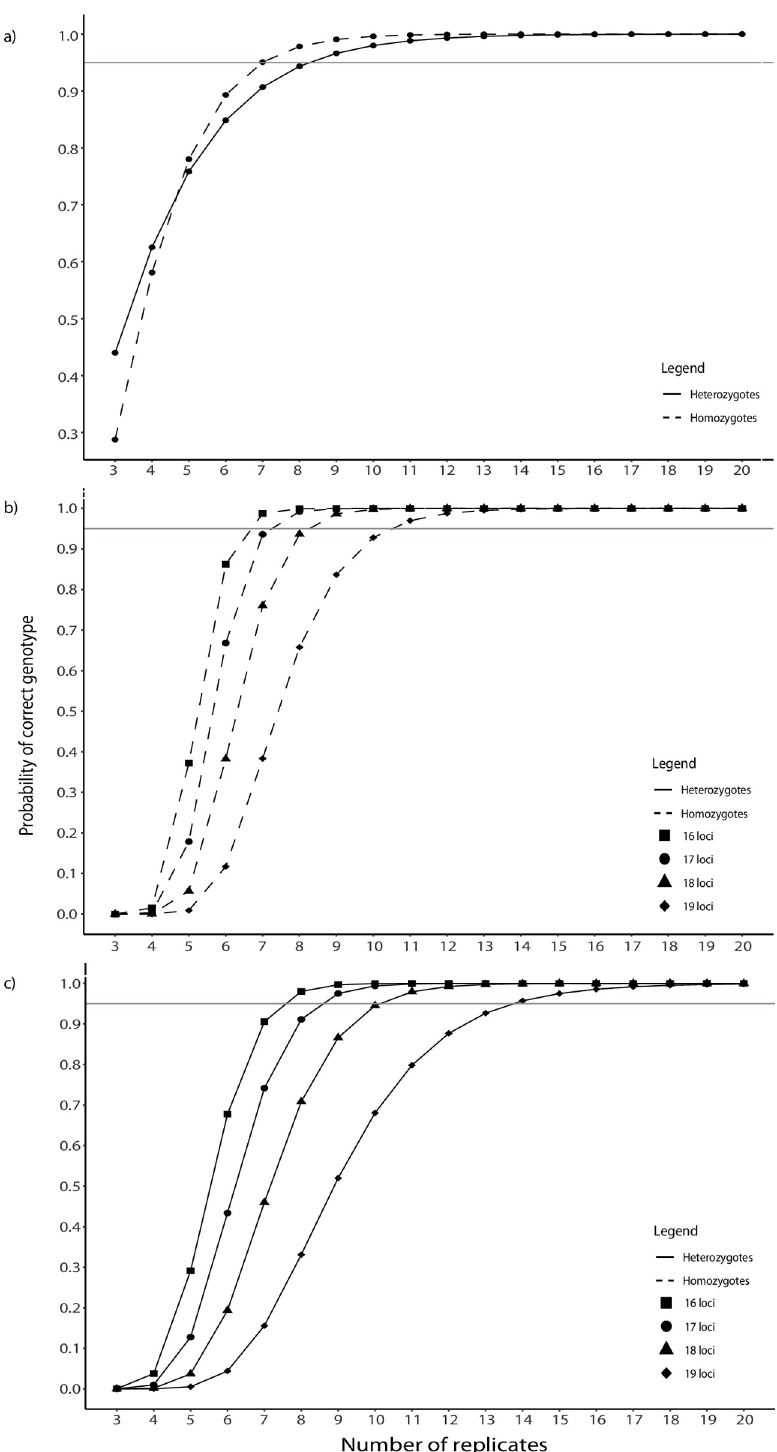
Fig 3. Relation between genotyping success and number of replicates using Megasat. Single locus (a): although the probability of genotyping success is higher for homozygotes (0.66; dashed line) than for heterozygotes (0.46; solid line), seven independent replicates are required to determine a homozygous genotype in a noninvasive sample, while eight were for a heterozygote. Multiple loci (b, c): Probability of obtaining the correct genotype for multiple homozygous (b, dashed lines) and heterozygous (c, solid lines) loci with different number of replicates. Considering a total of 19 loci,